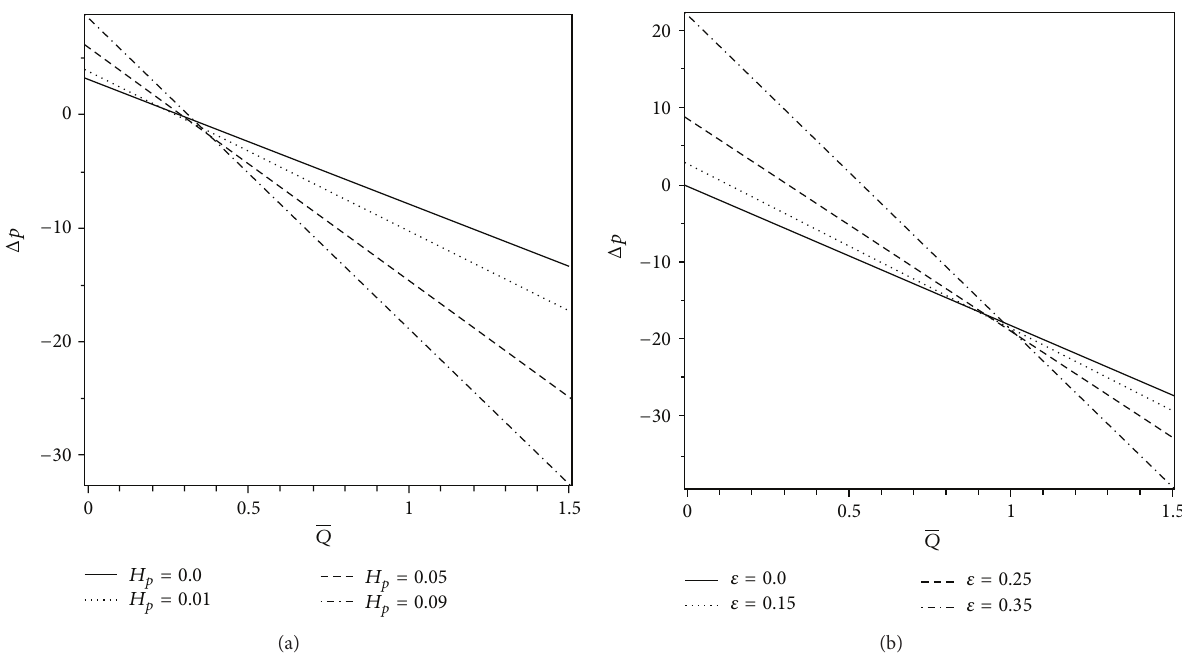
Figure 2: Variations of Δ𝑝 with 𝑄 for different values of (a) 𝐻 𝑝 when 𝜀 = 0.25 and (b) 𝜀 when 𝐻 𝑝 = 0.09 . The other parameters are 𝛼 = 0.4 and 𝛽 = 0.4